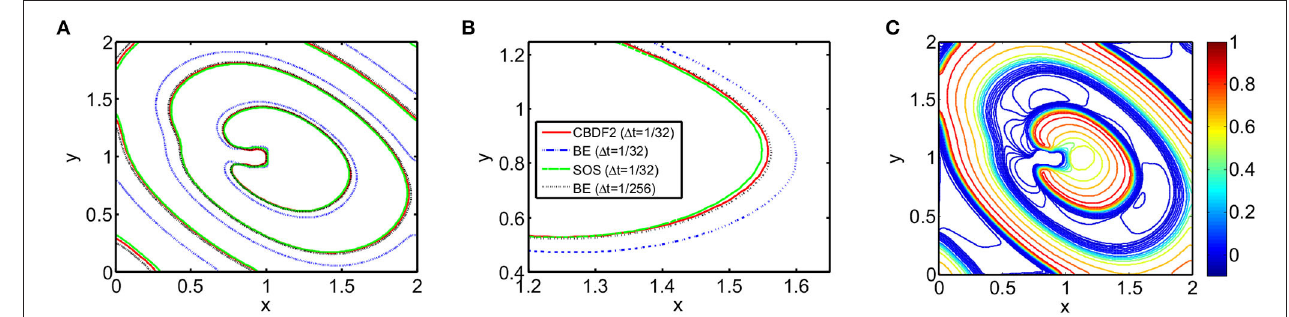
0.1 at time T 8.75 from different methods with timestep size 1 t 1 / 32 and spatial size h 1 / 64. A high precision solution = = = = 1 / 256 and spatial size h 1 / 256. (A) The isopotential lines in the entire computational domain. (B) A = =